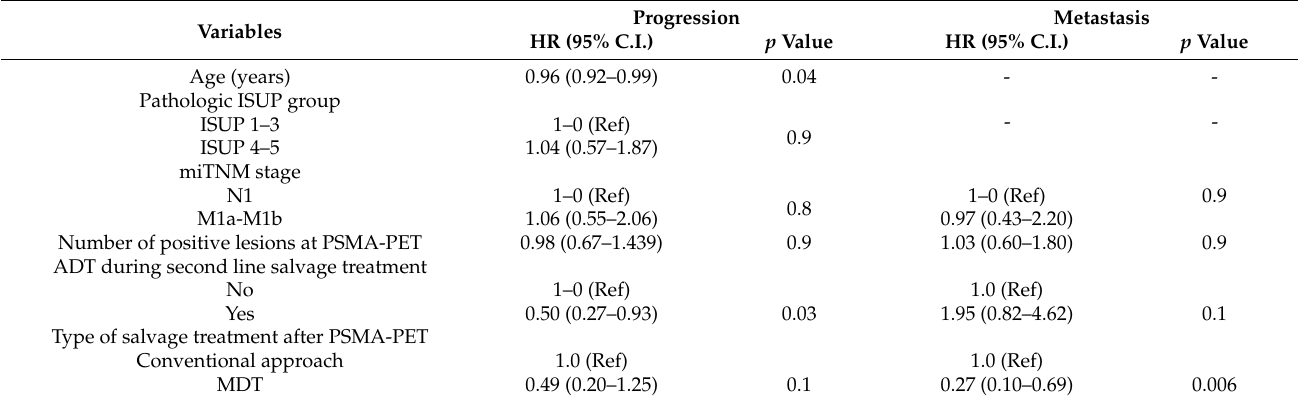
Table 3. Multivariate Cox regression to predict Progression free survival and Metastasis free survival in the overall population (n =